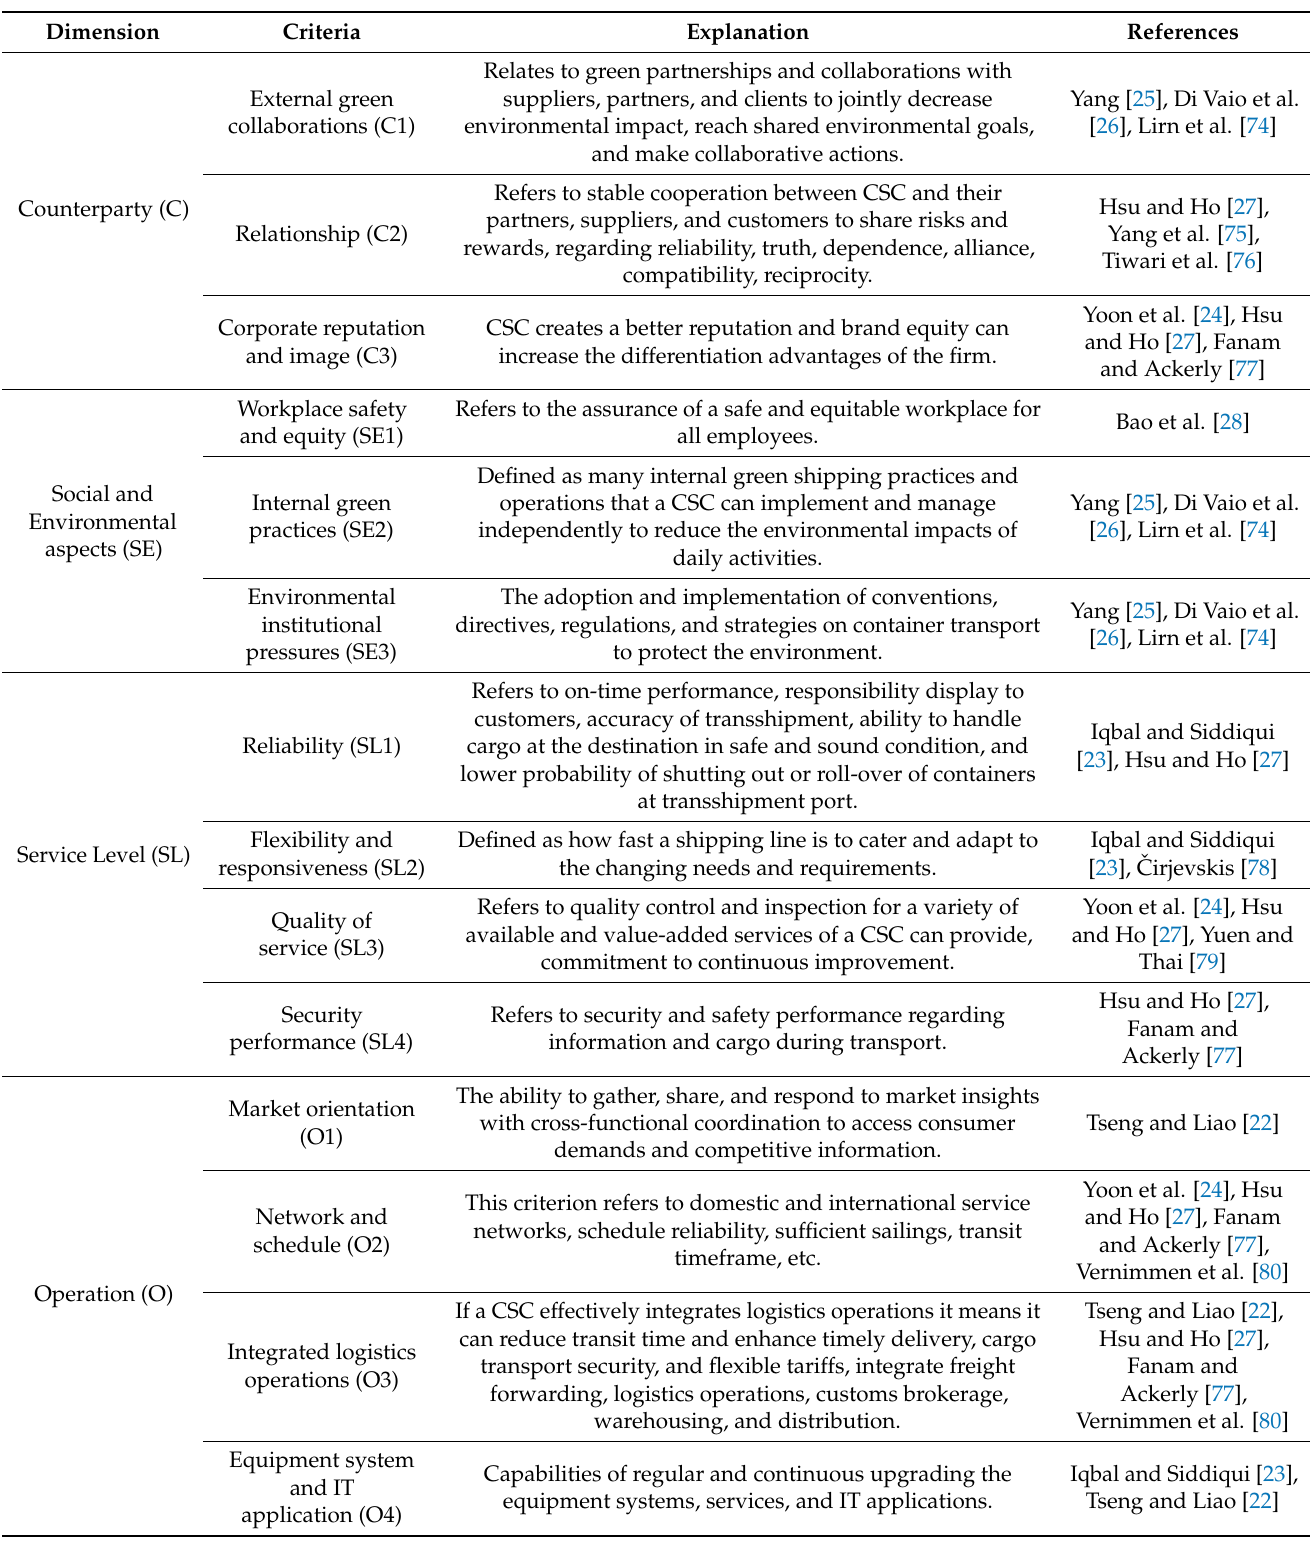
Table 5. The list of criteria and their